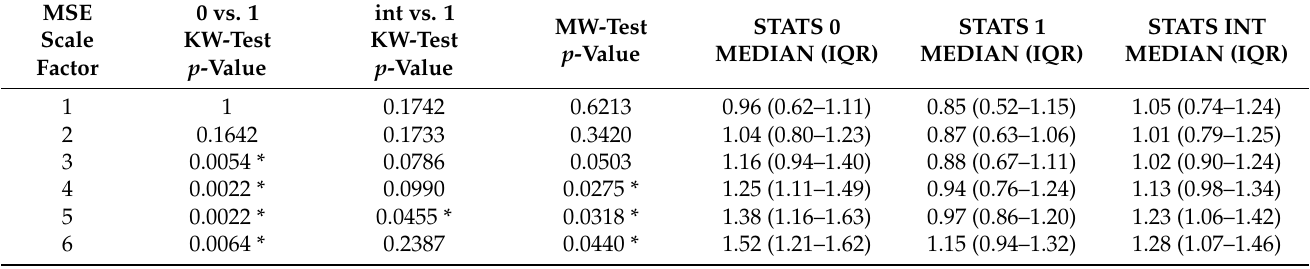
Table 2 reports the statistical analysis performed using MSE with embedding dimen- sion m = 2 and a scale factor from 1 to 6 for multiscale analysis. The statistics (median and IQR) for the three classes considered are shown. In Figure 3b, the MSE trends as a function of the scale factor are shown. As we obtained a significant p -value in the “int vs. 1” KW-Test, Figure 4 shows the boxplot of the three classes at scale 5. Table 2. Multiscale Sample Entropy—results of the test described in Section 2.6. Median and IQR values are reported for the three groups considered (0, 1, and int). Star (*) denotes statistically significant results. MSE